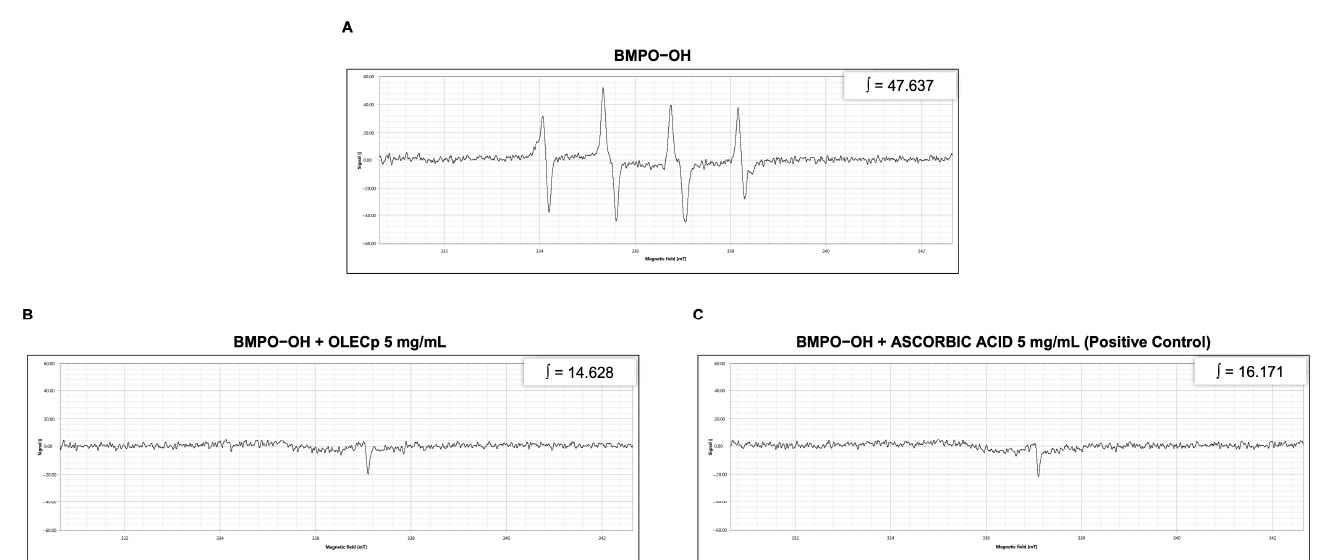
Figure 7. EPR spin trapping technique for hydroxyl radical scavenging activity. EPR spectra and respective signal areas ( ∫ ) of BMPO-OH adduct ( A ), BMPO-OH + OLECp ( B ) and BMPO-OH + Ascorbic Acid ( C ).